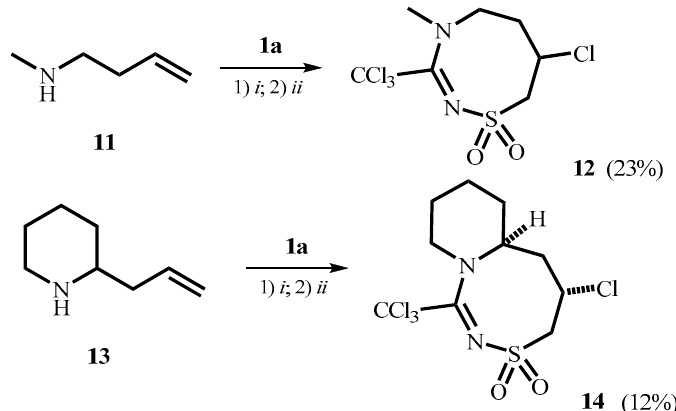
Molecules 2020 , 24 , x 7 of 21 Figure 4. Molecular structure of 5a ‐ chloro ‐‐ 3 ‐ trichloromethyl ‐ 4,5,5a,6,7,8,9,9a ‐ octahydro ‐ 1,2,4 ‐ benzothiadiazepine ‐ 1,1 ‐ dioxide 10 including thermal displacement ellipses with 50% probability. Next, we elongated chain between the amino nitrogen atom and double bond. Surprisingly, the heterocyclization of imidoyl chloride 1a with acyclic 11 , or cyclic alkenylamine 13 afforded, though in low yields, difficultly accessible thiadiazocine dioxides 12 , 14 , rather than expected seven ‐ membered heterocyles, diazepines (Scheme 5). In contrast to Schemes 2 and 3, cyclization in this case